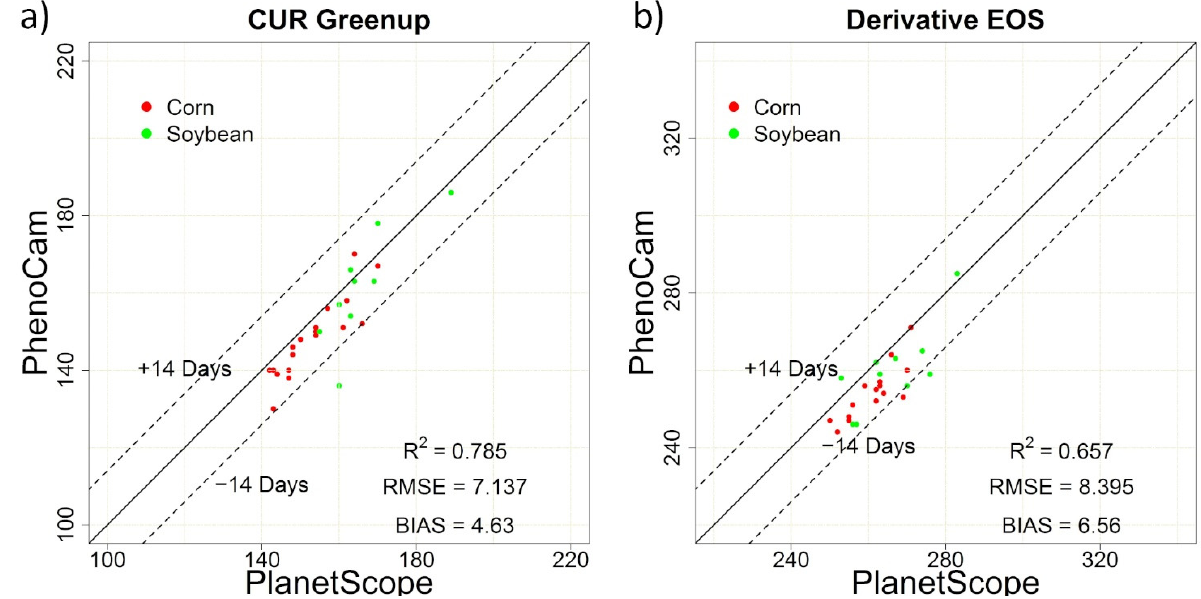
Figure 10. The comparisons between the PlanetScope- and PhenoCam-derived phenological metrics, including ( a ) CUR-based Greenup and ( b ) DER-based EOS, using all the shared site-year observations. Finally, we evaluated the concordance among PlanetScope, PhenoCam, and visual phenology with all the shared site-year observations using the CUR-based Greenup and DER-based EOS (Figure 11 and Table 4). Both PhenoCam- and PlanetScope-derived metrics showed a good relationship with crop visual phenological observations. By comparison with visual crop emergence, PhenoCam-derived CUR Greenup estimates were within one week difference (RMSE = 6.43 days), almost no bias, and attained the R square of 0.73. The PlanetScope-based Greenup estimates showed a slightly positive bias (5.28 days), partly due to the use of PhenoCam imagery for visual phenological assessments. Similarly strong correspondence with visual crop maturity was found for both PhenoCam- and PlanetScope-based DER EOS (RMSE = 5.31 days and R square = 0.70 for PhenoCam; RMSE = 9.92 days and R square = 0.58 for PlanetScope), with PlanetScope estimates slightly positive biased (bias = 8.16 days). The congruence among PhenoCam, PlanetScope, and time series from the RGB imagery to identify critical crop phenological stages, as well direct comparisons between PlanetScope and visual phenology, along with those between PhenoCam and visual phenology, indicated the linkage of these fine-scale sensors in terms